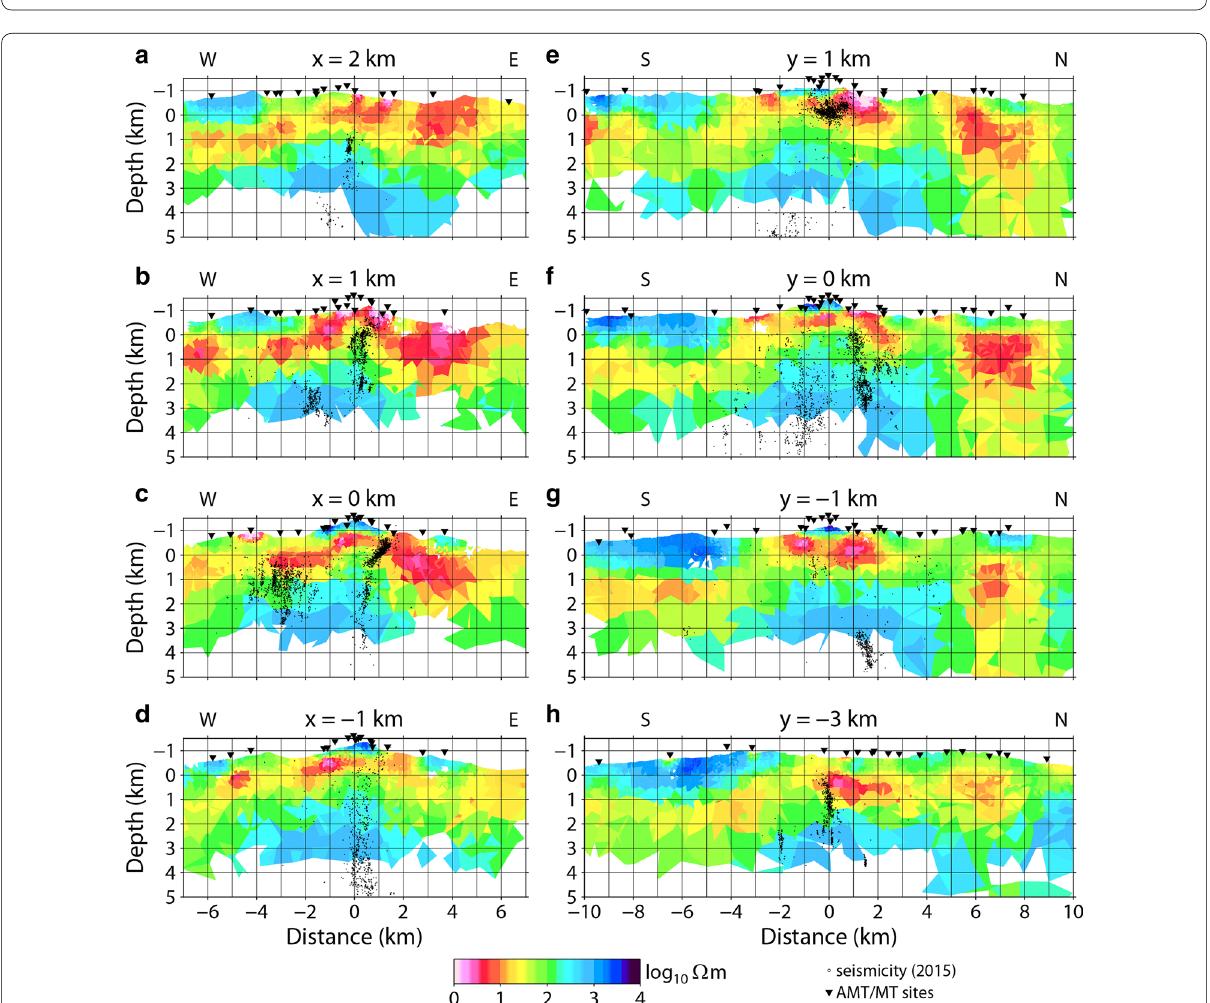
Fig. 4 Vertical cross sections of the three‑dimensional resistivity structure. Only the elements for which the model results exceeded the sensitivity and sensitivity density criteria (vertical black lines in Fig. 3) are plotted. Only the subsurface elements are shown here. a – d cross the study area in the E–W direction at x 2, 1, 0 and 1 km, respectively. e – h cross the study area in the N–S direction at y 1, 0, 1 and 3 km, respectively. The = − = − − inverted black triangles indicate the AMT/MT measurement sites located within 1.5 km of each profile. The earthquake hypocentres determined ± by Yukutake et al. (2017) that occurred within 0.25 km of each profile are also plotted as black dots. See Fig. 1 for the profile locations, AMT/WMT ± sites and earthquake